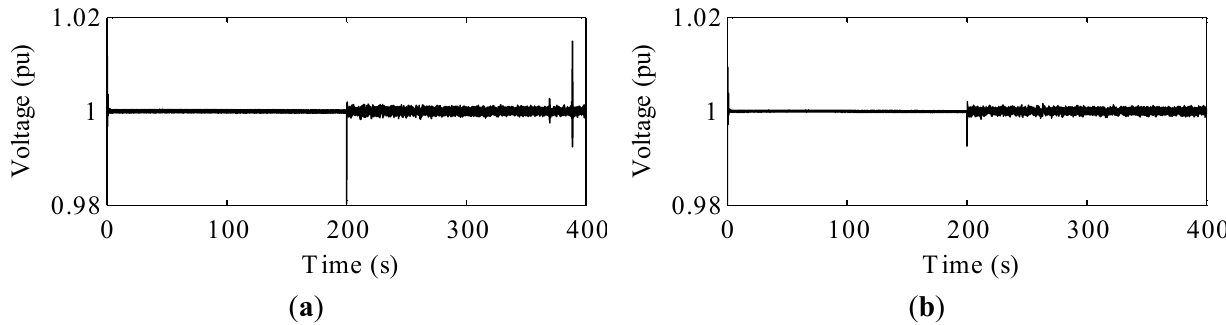
Figure 10. Frequencies of the microgrid system: ( a ) microgrid with the conventional FES system; ( b ) microgrid with the proposed FES system.